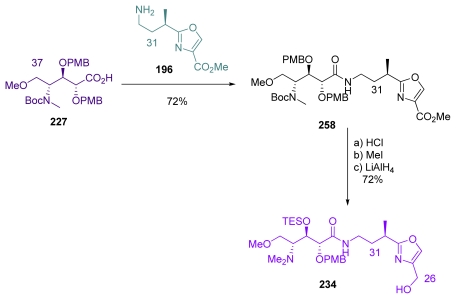
Preparation of the C26–C37 fragment 234 by Barrett.